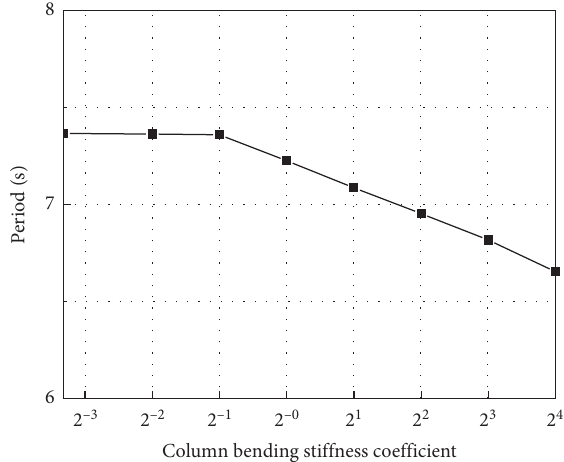
Figure 9: Influence of the column section axial stiffness on the period.